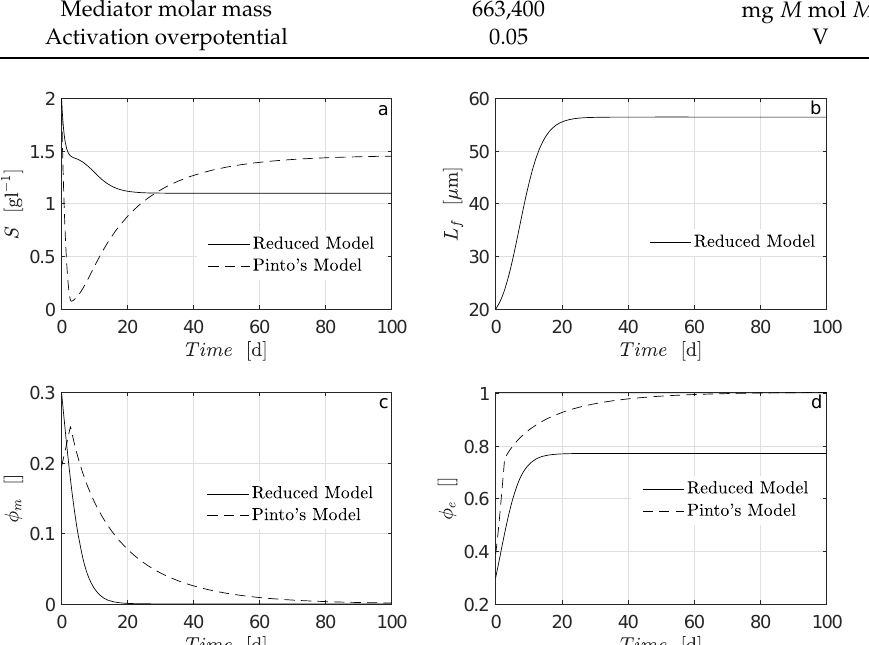
Figure 7. Open-loop numerical simulation of reduced model in (21) and Pinto’s model in (23) for: ( a ) substrate, ( b ) biofilm thickness, ( c ) mass fraction of methanogenic microorganisms, and ( d ) mass fraction of exoelectrogenic